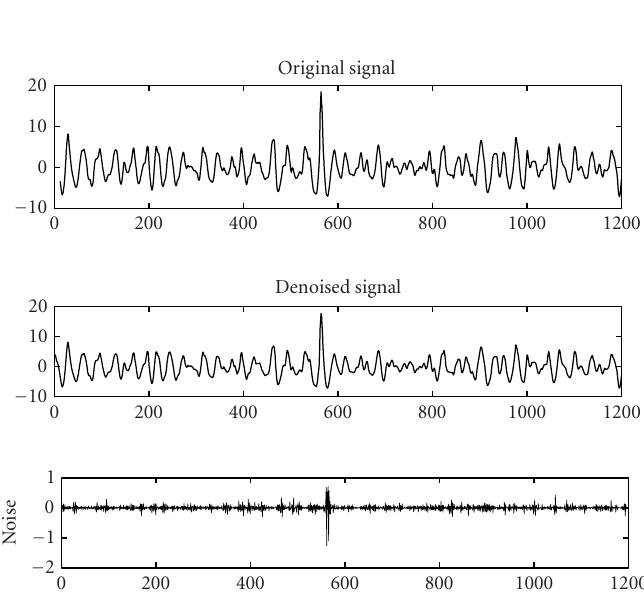
Figure 3.10. Wavelet spectrum with Coiflet3.